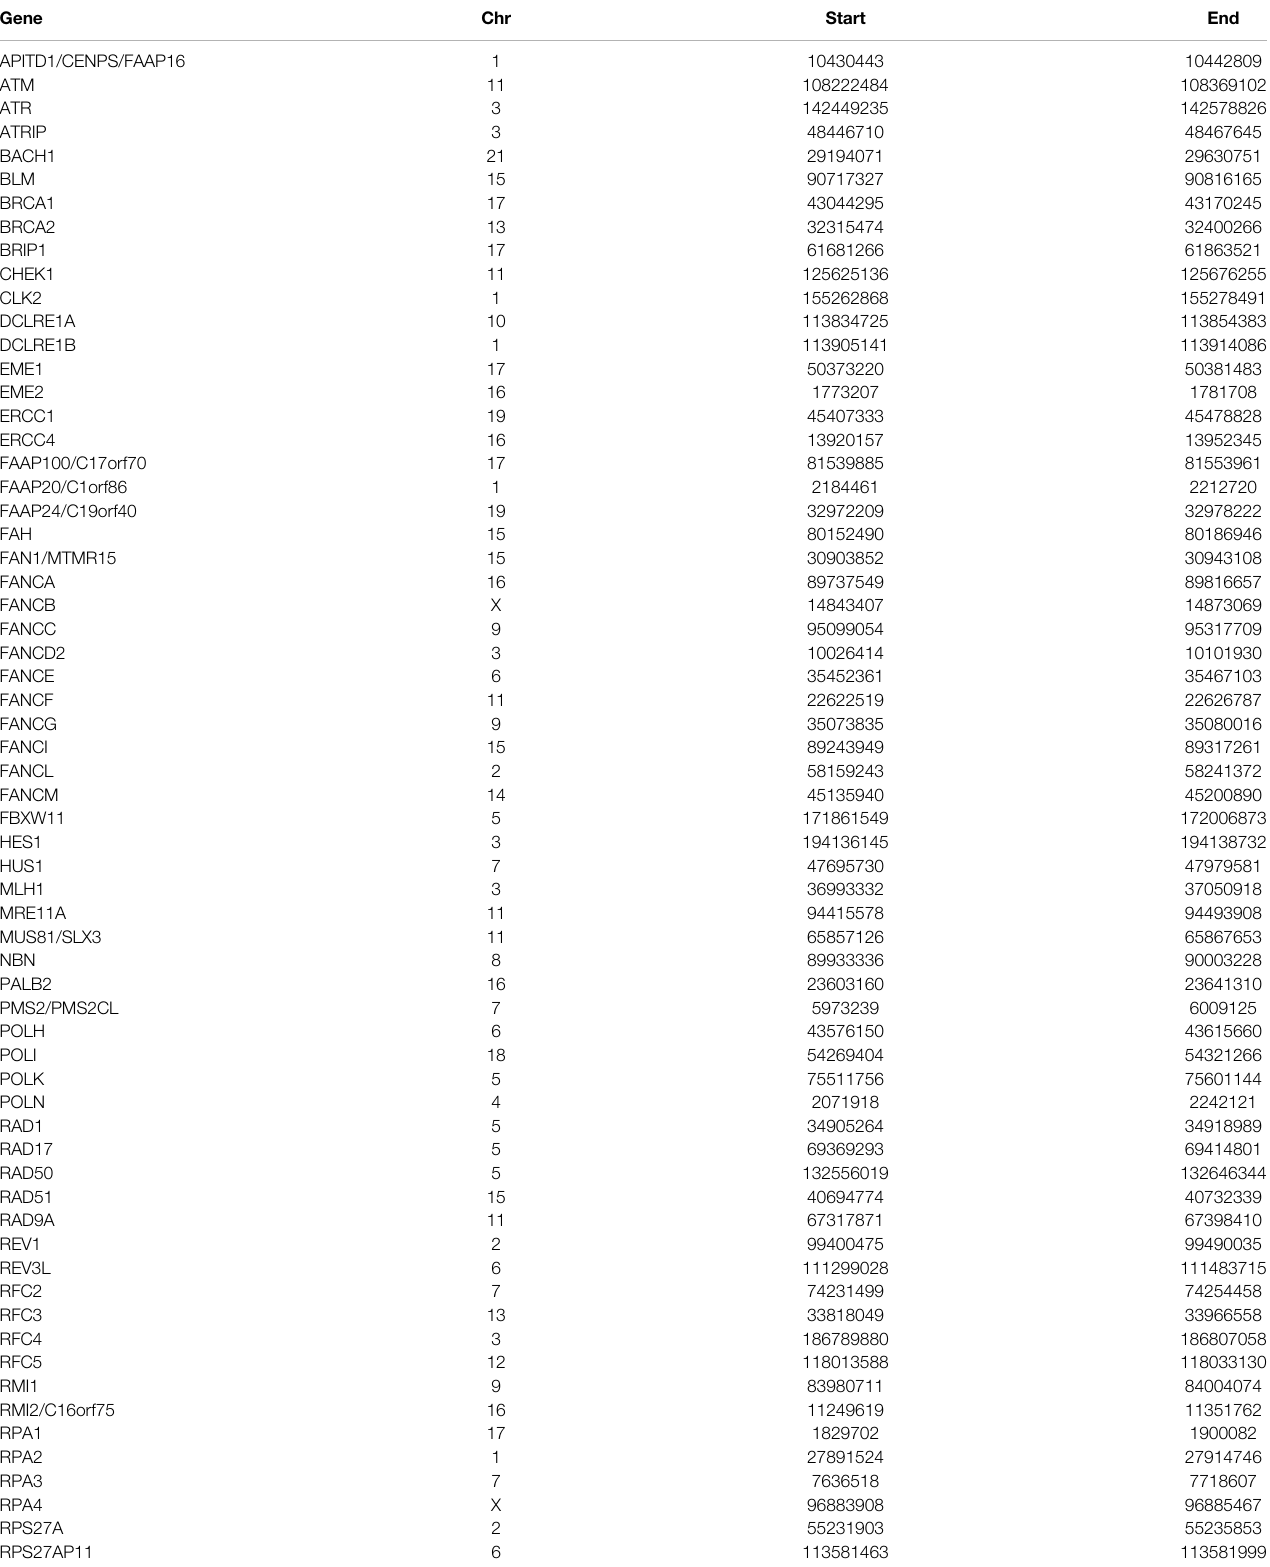
TABLE 1 | FARGs and its location on the